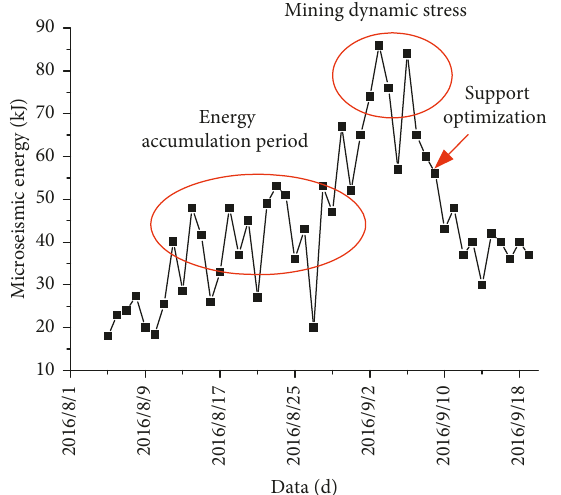
Figure 21: Distribution of roadway microseismic